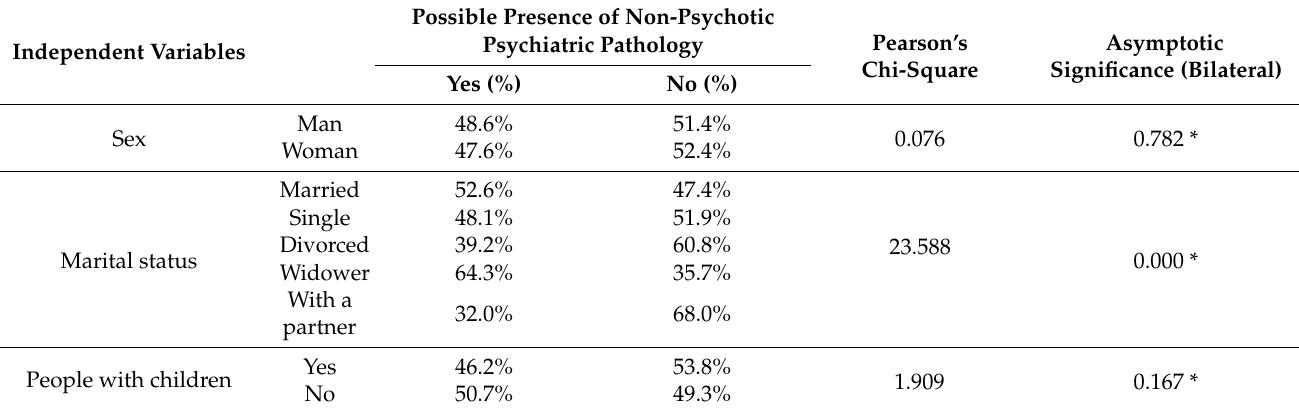
1 Grouping variables: GHQ-12 results. * p -value of the chi-square